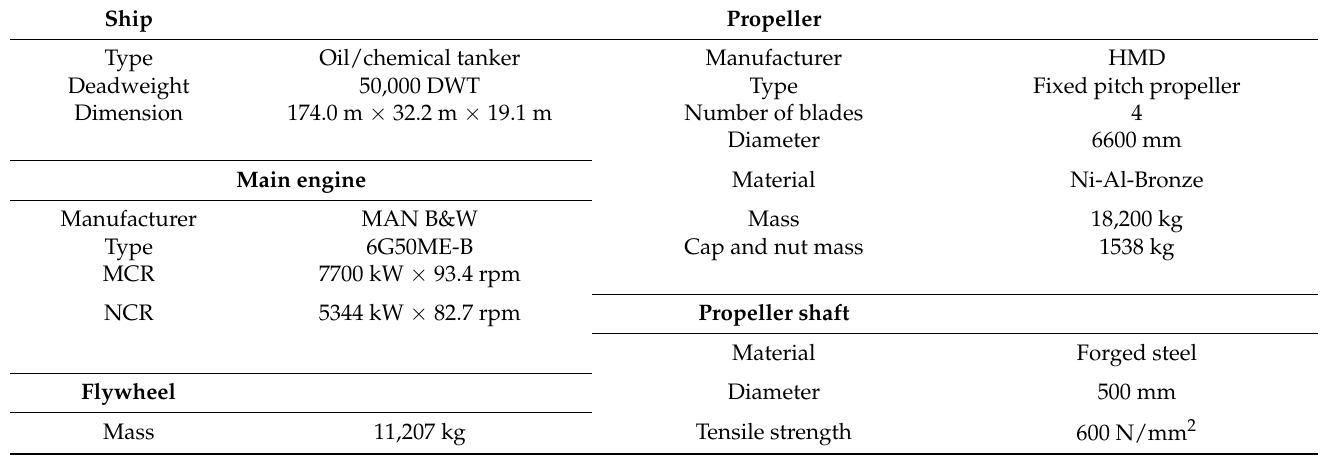
Table 1. Specifications of ship and propulsion